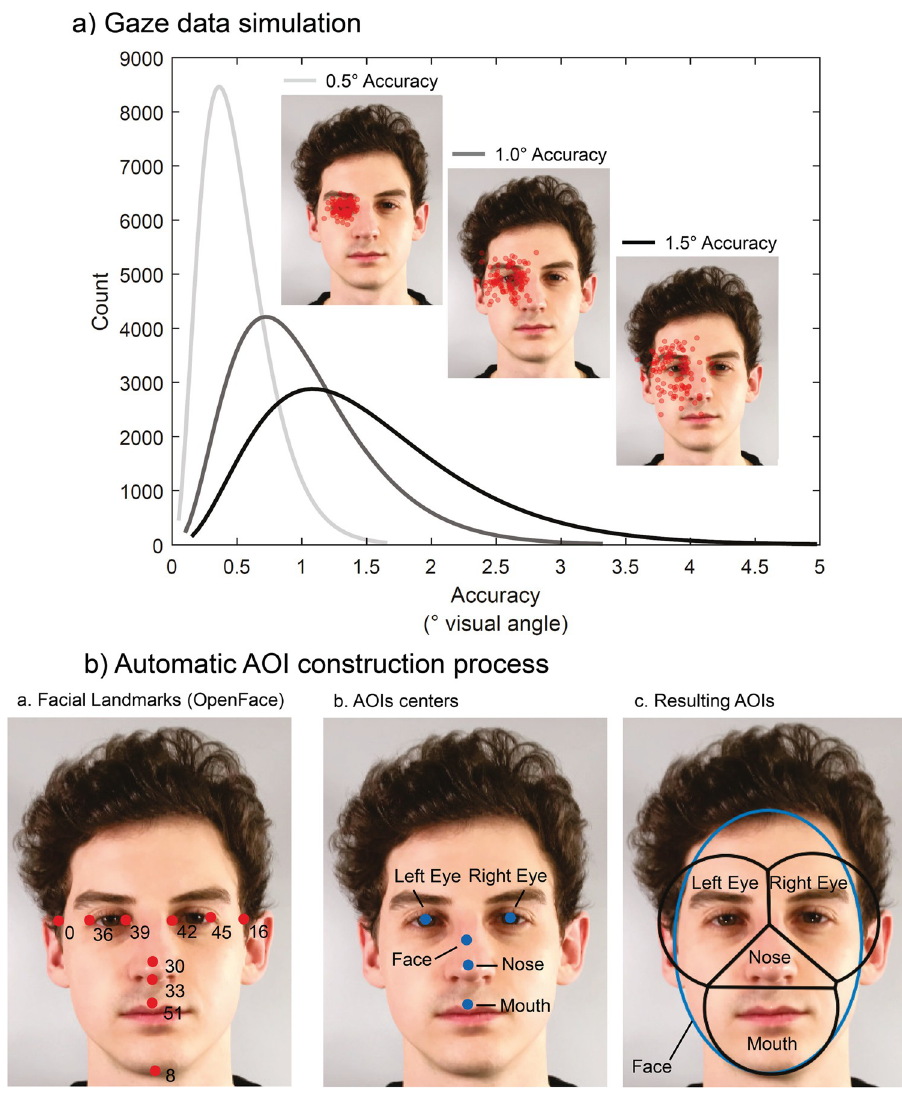
Fig 1. Visualization of gaze data simulation and areas of interest (AOI) definition. (A) Visualization of the three gamma functions used to generate gaze data with three levels of accuracy (0.5˚, 1.0˚ & 1.5˚) and examples of the simulated fixations for the left eye of a facial stimulus as the facial target. Each red dot represents the averaged fixation location of 30 simulated fixations; a total of n = 100 data sets were simulated. (B) Visualization of the three steps of the automatic AOI construction process. 1. Facial landmarks from OpenFace. 2. AOI center points derived from the facial landmarks. 3. Resulting AOIs using the Limited-Radius Voronoi-Tessellation (LRVT) method (example with 2.0˚ radius). Note OF = OpenFace [19]. The stimulus shown in A and B was created for illustrative purposes only and is not part of the stimulus set used in the study (see Methods section).